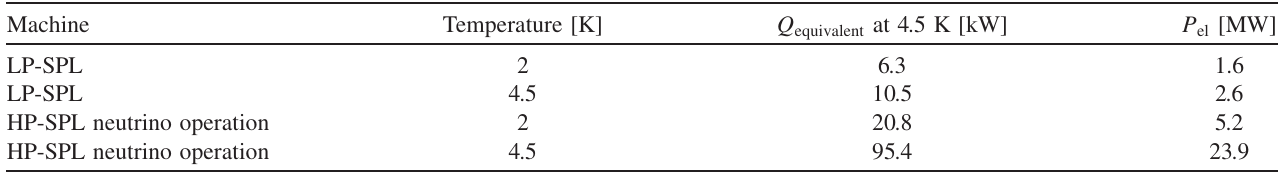
TABLE XVI. Cryogenic plants for 704.4 MHz, considering a 4 GeV LP-SPL and a 5 GeV HP-SPL. Machine